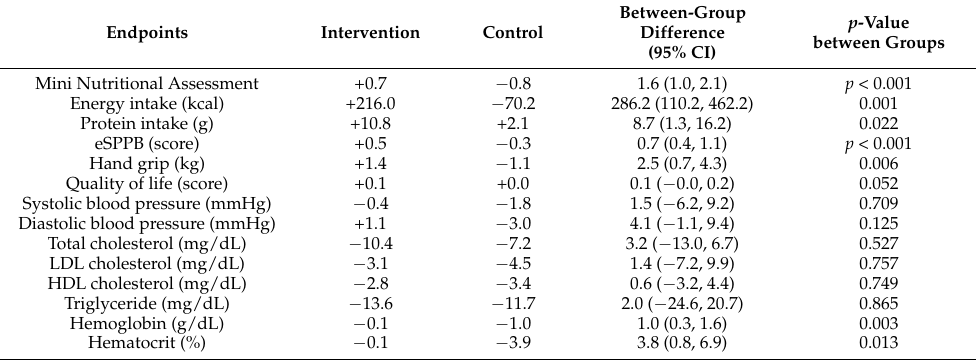
Table 4. Results of endpoints